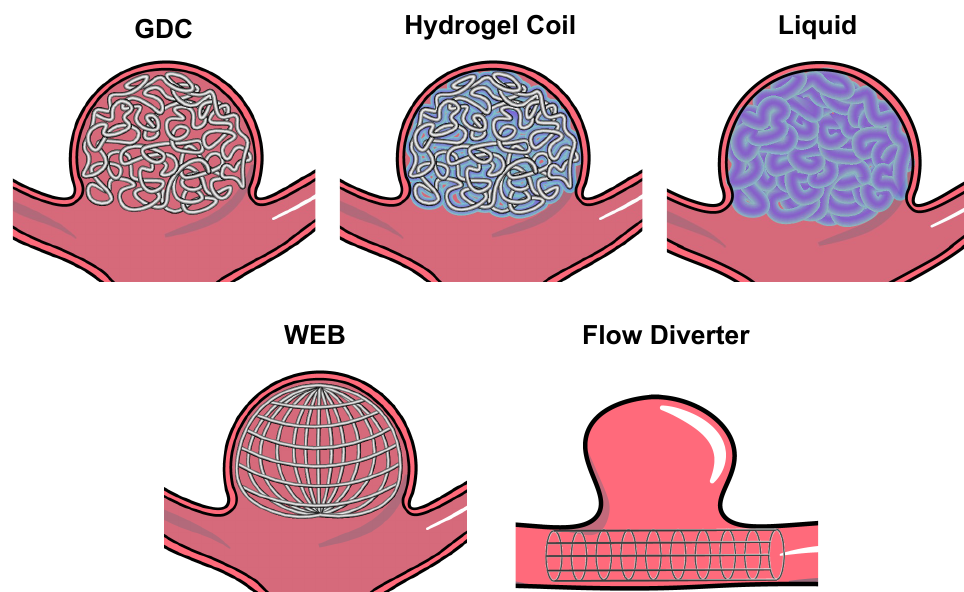
Figure 3. Schematic of different state-of-the-art endovascular devices for occluding (i) “bifurcation” aneurysms (e.g., GDCs, hydrogel coils, liquid embolic devices, and woven EndoBridge—WEB); and (ii) “side-walled” aneurysms (e.g., flow